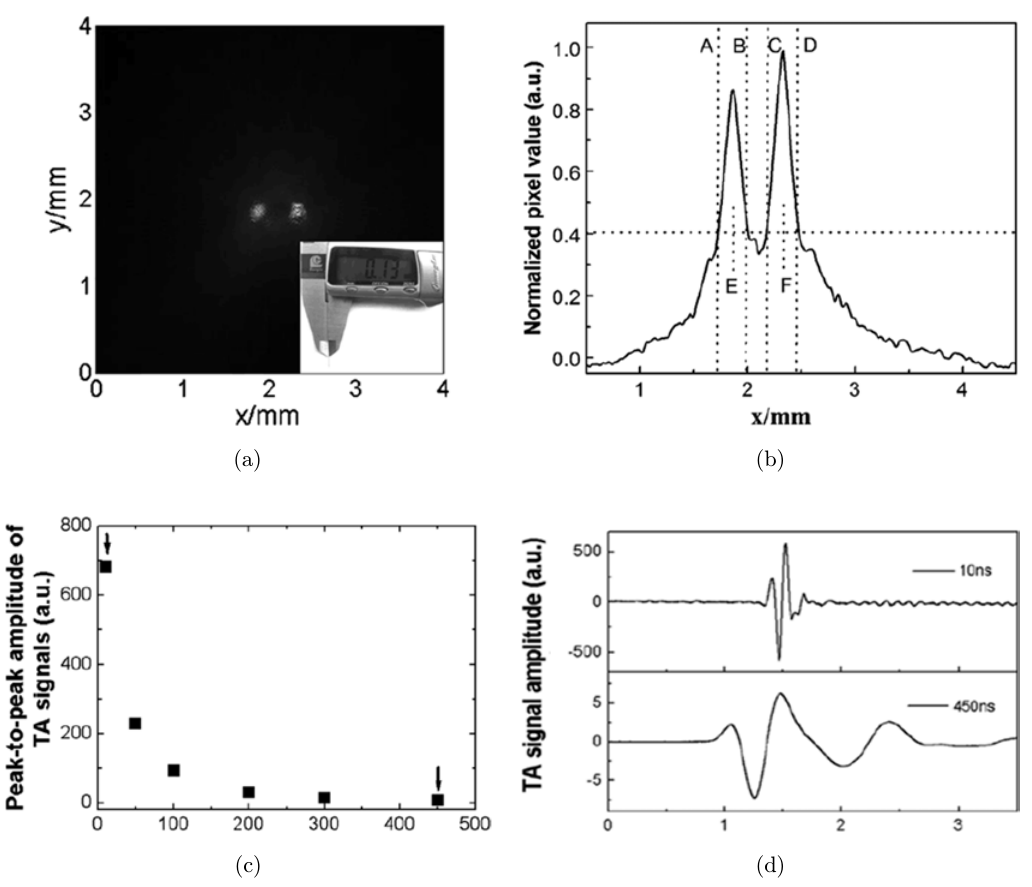
Fig. 5. Spatial resolution of the USMP TAI system. (a) TAI of two copper wires (0.13 mm in diameter). The inset ¯gure at the bottom-right corner shows the diameter of the wire. (b) Line pro¯le of the reconstructed image shown in (a) with y ¼ 1 : 84 mm. (c) The simulated peak-to-peak amplitude of TAI signal of the USMP and the microsecond-level TAI. (d) The experimental results of TAI signal amplitude.